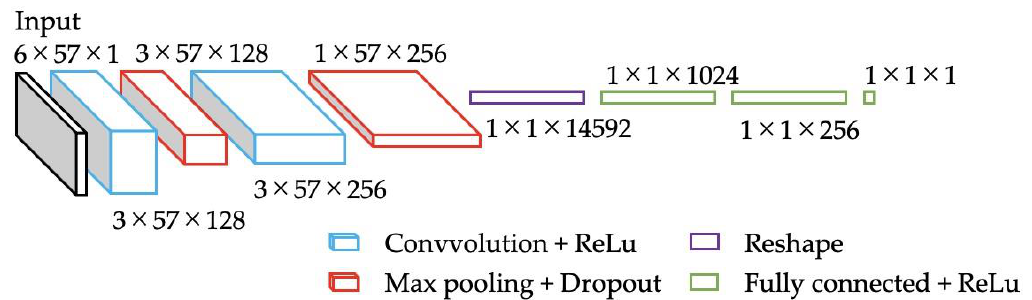
Figure 9. The architecture of the designed model (not to scale).